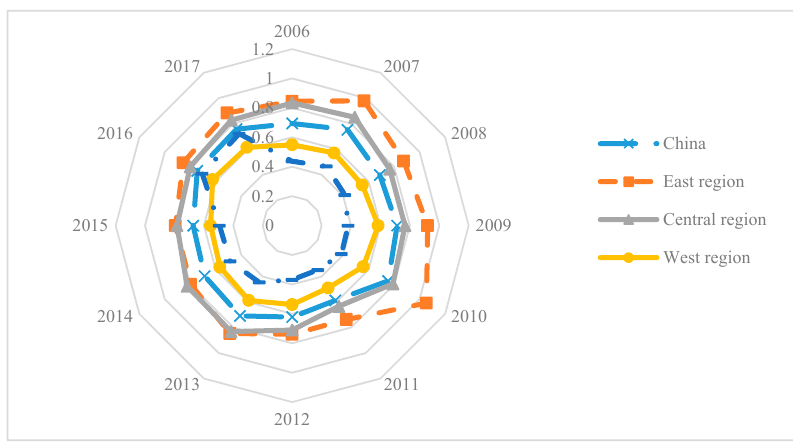
Figure 4. Average EWP values in the different Chinese regions from 2006 to 2017.